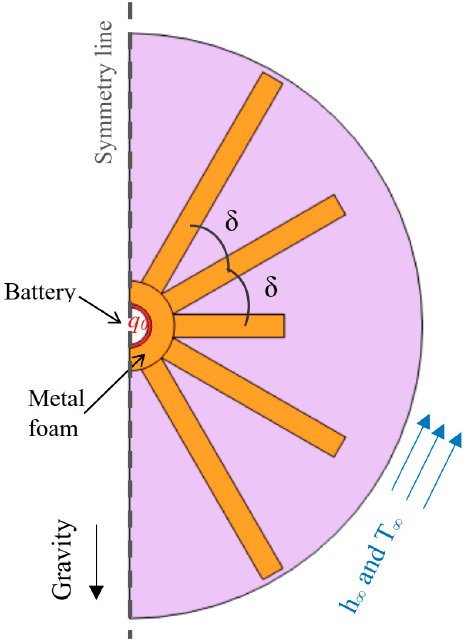
Figure 1. The physical model of the battery and PCM heatsink, and metal foam fins.